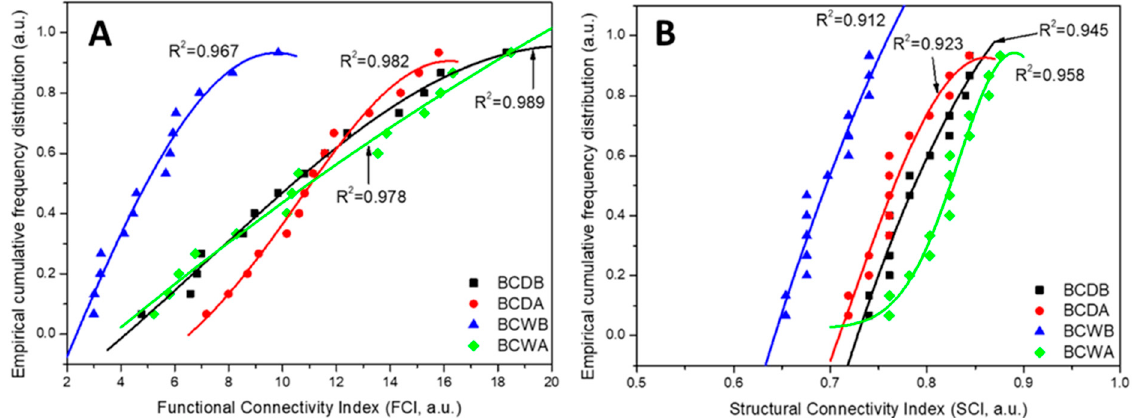
Figure 2. The empirical cumulative frequency distribution for both FCI ( A ) and SCI ( B ) acquired at different proton Larmor frequencies (points) reveals a normal distribution shape (continuous lines). Hence, it can be suggested that the FCI and SCI values at each ν L can be averaged to obtain FCI and SCI mean values and standard deviations. The coefficients of determination reported in the figure were obtained by fitting the points with the normal distribution equation. In the legends, BC stands for biochar, D and W stand for dry − quench and wet − quench, respectively, B and A stand for before and after application to soil.